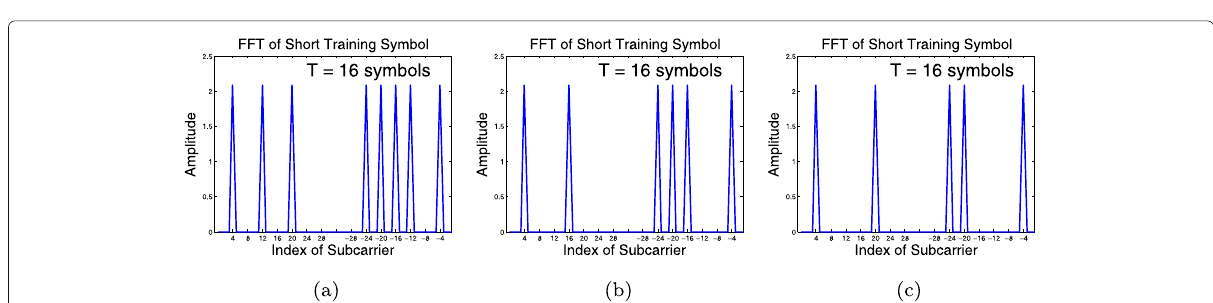
Fig. 8 Observation 4: filtering some non-contiguous subcarriers in both sidebands out does not change period of STS. a Filter subcarrier No. -8, 8, 16. b Filter subcarrier No. -12, -8, 8, 12, 20, 24. c Filter subcarrier No. -16, -12, -8, 8, 12, 16, 20,